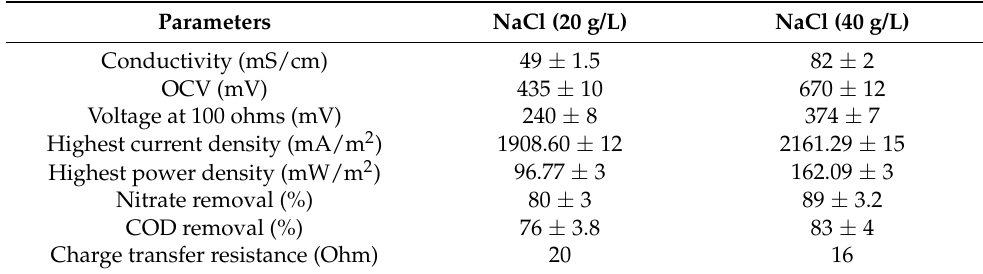
Table 2. Comparison of the data obtained for MFCs operating at different NaCl concentrations (Initial